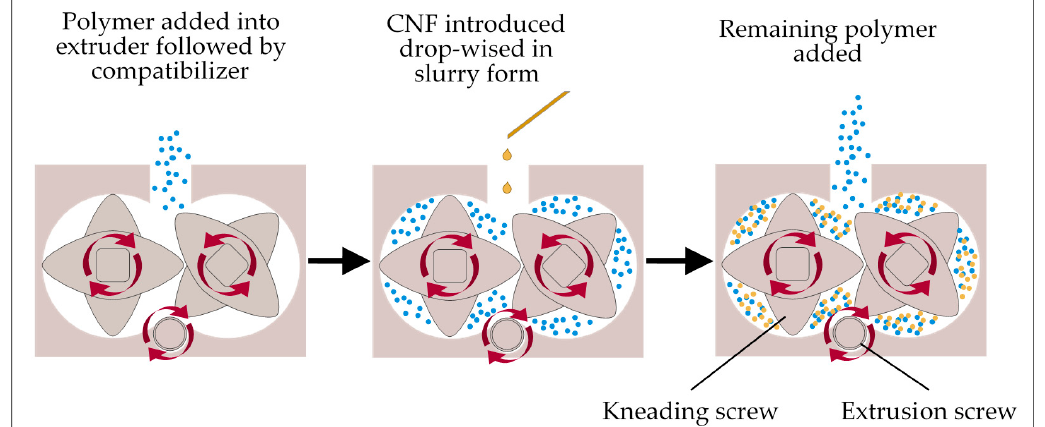
Figure 10. Preparation of UHMWPE/CNF bionanocomposite by using a triple screw kneading